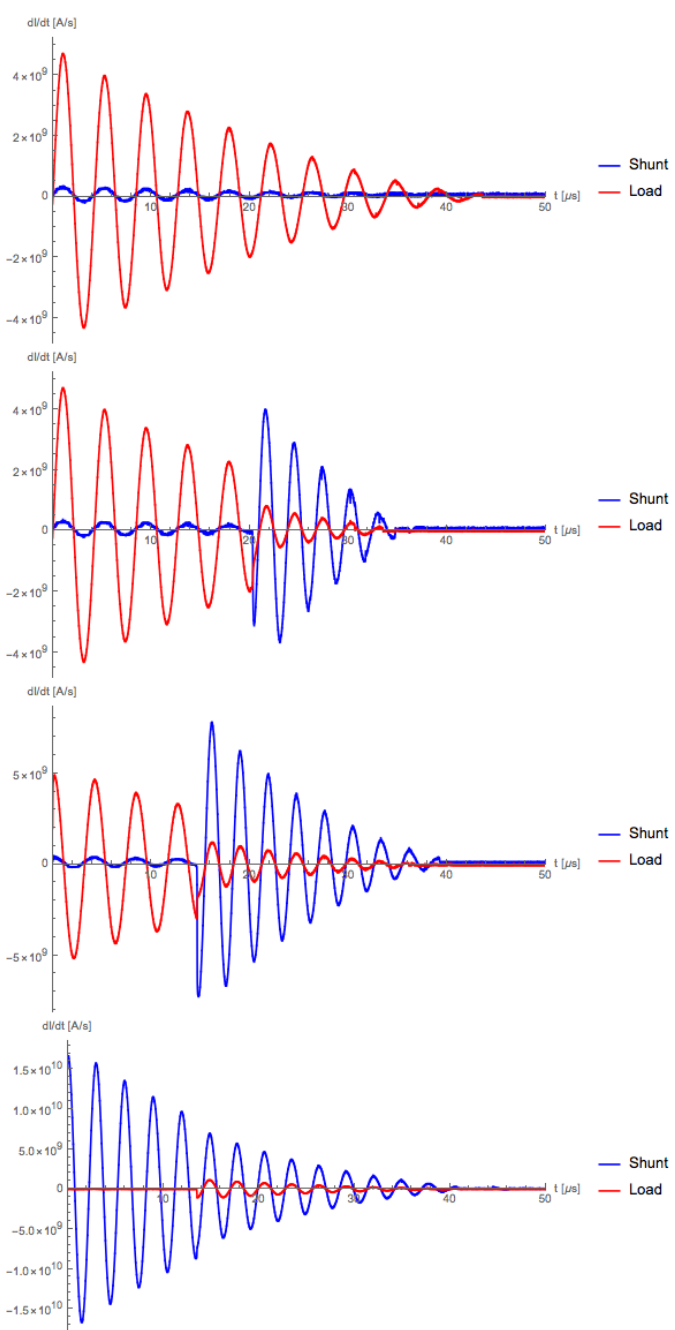
Figure 5. dI/dt traces with shunt-to-centerline distances of 14 mm, 12 mm, 10 mm, and 8 mm, respectively.